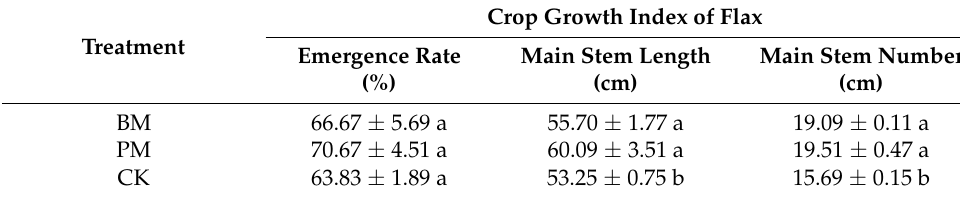
Table 2. Agronomic characters of flax covered with BM paper film and PM white film.